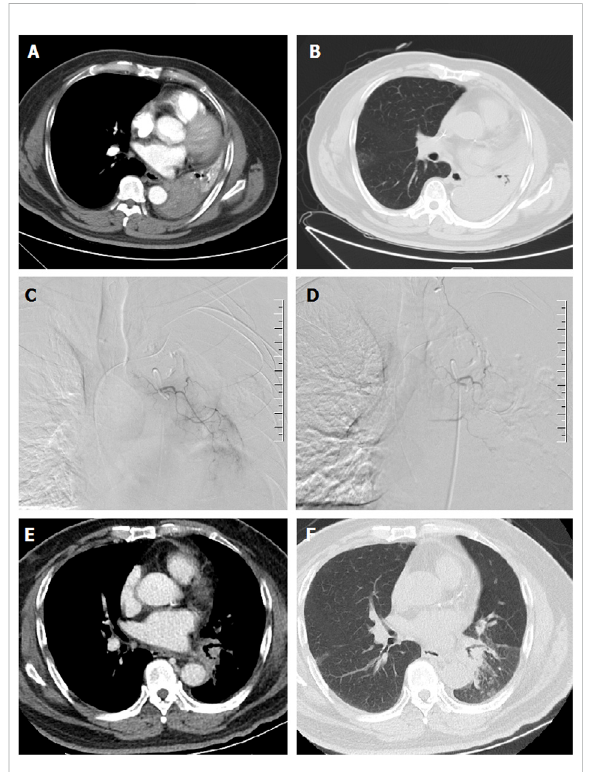
FIGURE 3 A 67-years male treated by CalliSpheres beads for advanced squamous cell carcinoma. (A,B) Computed tomography preoperative examination revealed a large tumor of the left lung with complete atelectasis. (C,D) The left bronchial artery was super-selectivelyincubatedandembolizedbydrug-loaded beads. (E,F) The left lung tumor was found to shrink and the left lung atelectasis disappeared after 2 weeks ’